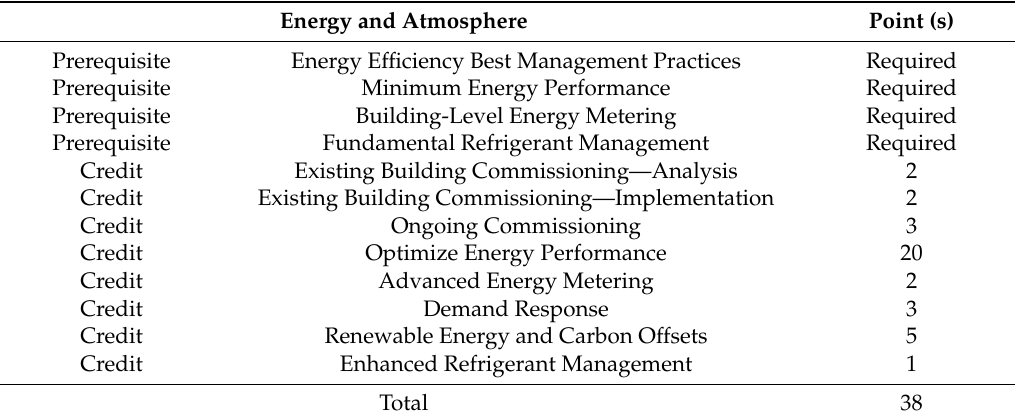
Table 1. Credits and Points of Energy and Atmosphere in LEED EBOM (Data Source: USGBC